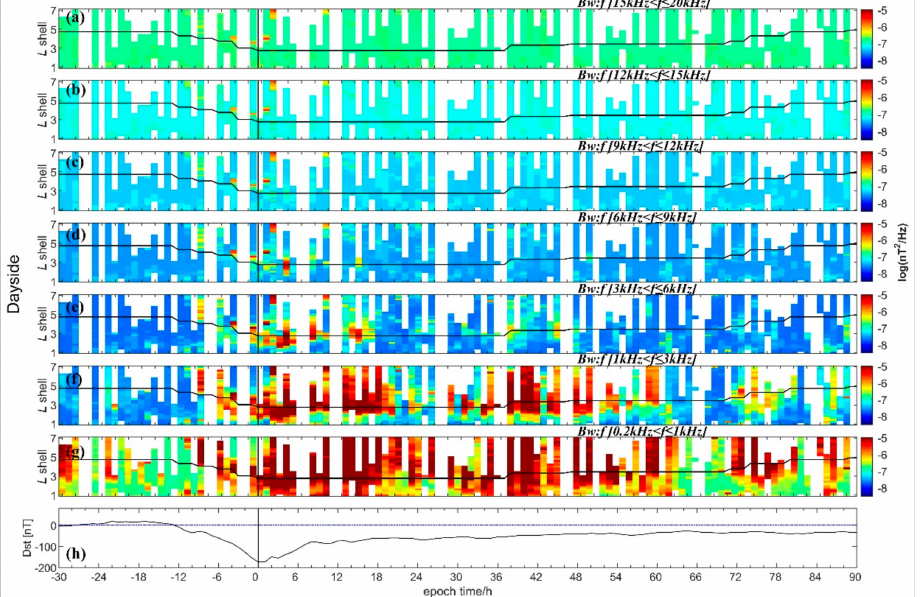
Figure 4. The temporal and spatial evolution of the ionospheric ELF/VLF wave intensities at frequency range from 0.2 to 20 kHz at the magnetic field in the dayside ionosphere, revealed by the search-coil magnetometer (SCM) onboard the China Seismo-Electromagnetic Satellite (CSES) during the geomagnetic storm on 26 August 2018. From top to bottom: the PSD values at different frequency bands of ( a ) 15–20 kHz, ( b ) 12–15 kHz, ( c ) 9–12 kHz, ( d ) 6–9 kHz, ( e ) 3–6 kHz, ( f ) 1–3 kHz, and ( g ) 0.2–1 kHz. The overlapping black curves denote the location of plasmapause estimated by the ( h ) Dst index. The vertical dashed line denotes the time of the Dst